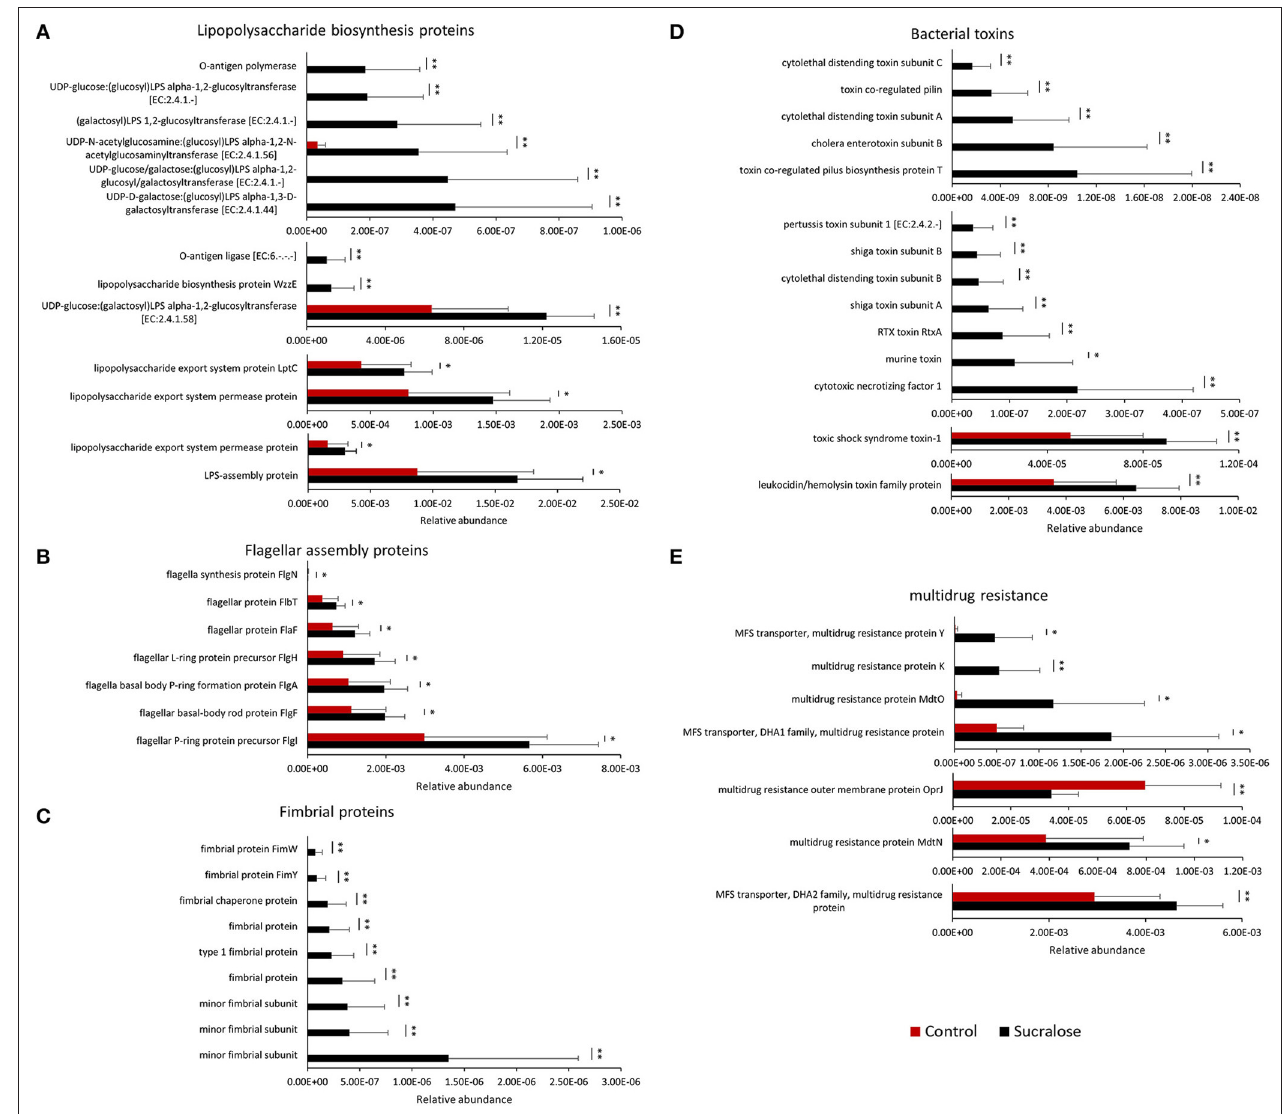
FIGURE 2 | Enrichment of bacterial pro-inflammatory genes after 6 months of sucralose treatment (* p < 0.05, ** p < 0.01), including genes involved in LPS (A) , flagella (B) , and fimbriae synthesis (C) as well as toxins (D) and multidrug resistance genes (E)